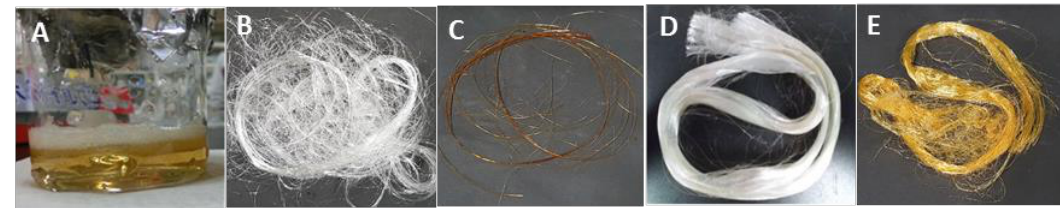
Figure 2. Appearances of the dope solution and resultant fibers: ( A ) aqueous gelatin solution before spinning; ( B ) gel fibers without crosslinking; ( C ) GlcNAc-crosslinked fibers; ( D ) denacol-crosslinked fibers; and ( E ) GTA-treated